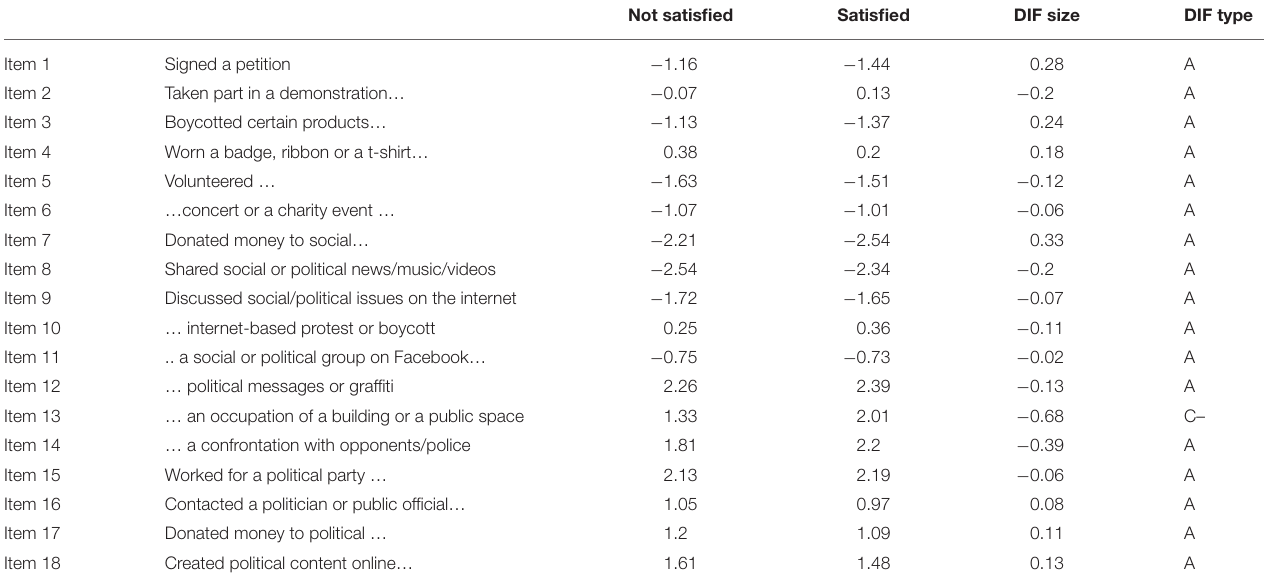
TABLE 8 | DIF based on income satisfaction (satisfied vs. not satisfied).